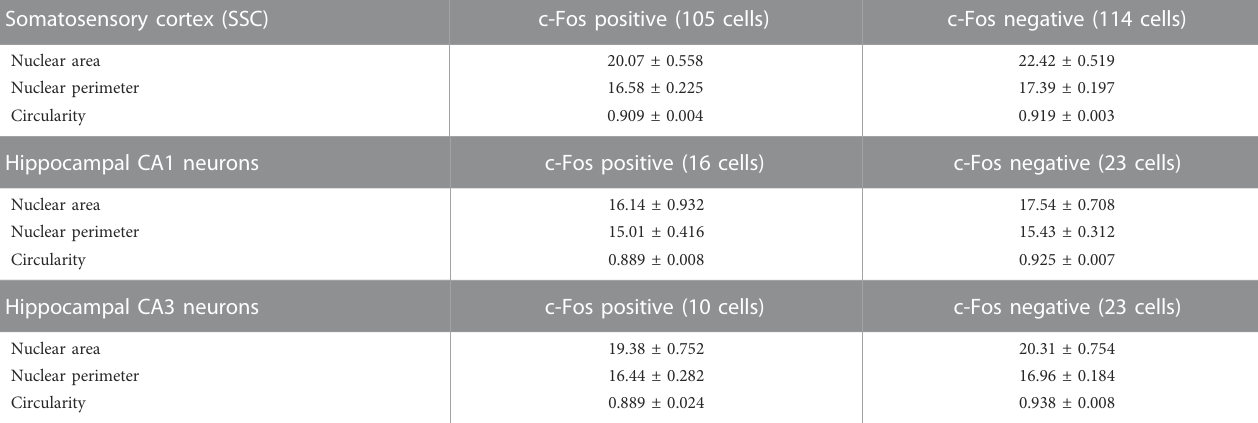
Circularity n = 3 mice. Data shown as Mean ± SEM.